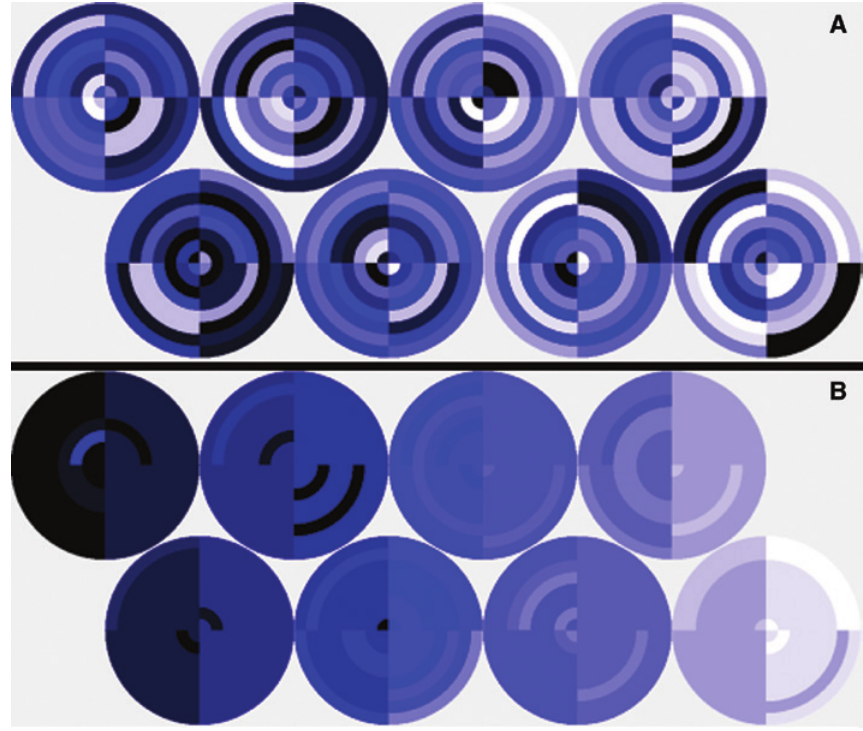
Figure 5: Best Individual from (A) Initial Population and (B) All Generations, for Experiment 6.